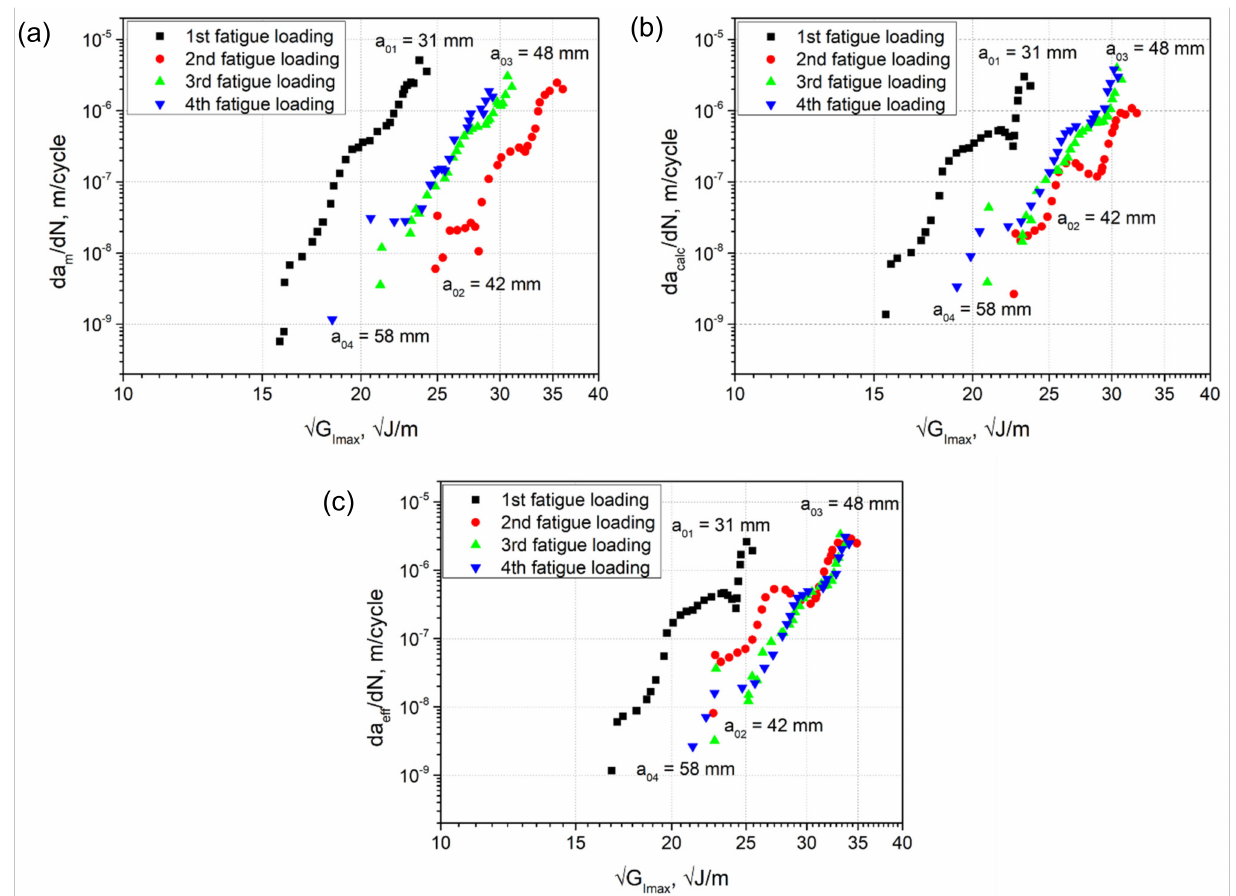
Figure 12. Fatigue crack growth curves of a sequential series of fatigue loadings performed on one DCB specimen (c- 10-350) for: ( a ) a m measured visually with the microscope; ( b ) a calc calculated using Equation (2); ( c ) a ef f calculated using Equation